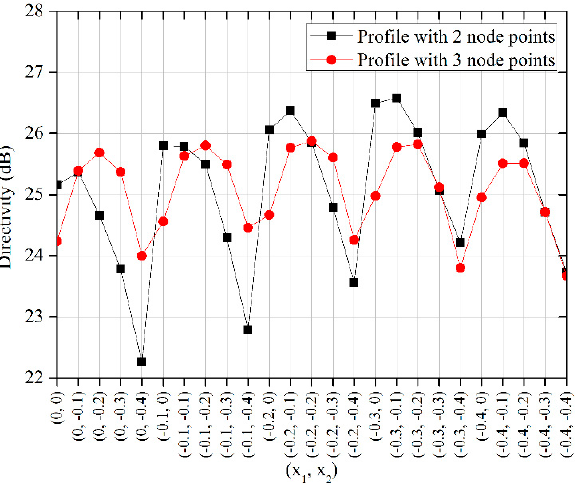
Figure 6. Comparison of directivity (at 140 GHz) for horn antennas with 2 and 3 node points.